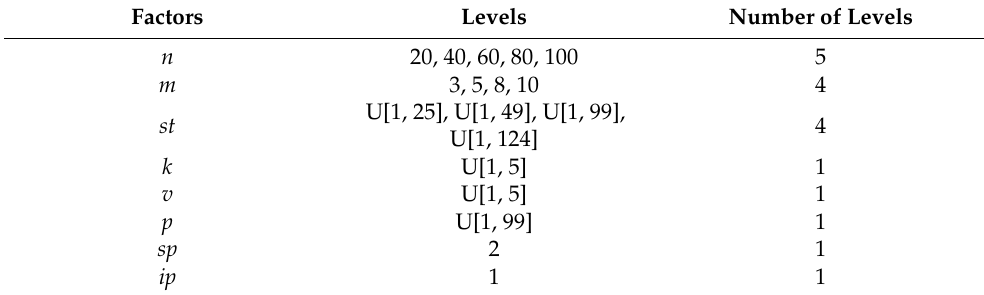
Table 2. Summary of test